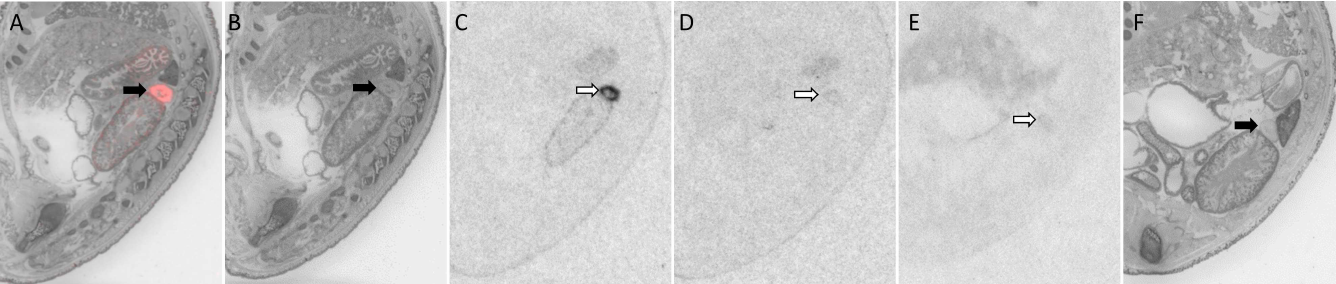
Fig 4. OXTR ligand binding in the adrenal gland of a P0 male mouse. Pseudo-colorcomposite (OXTR in red, cresyl violet counterstain in gray) (A), followedby cresyl violet counterstain (B), with black arrows indicating region of interest. OXTR ligandbindingis indicatedby white arrows in the 0 nM OXT competition(C), followedby 1000 nM OXT competingwith OVTA radioligand to reduce the signal(D). Specific bindingcan be observedon the kidney (C) just belowthe adrenalgland, and this is also competedaway by 1000 nM OXT (D). Nonspecificbindingto lipids in the duodenumcan be seen above the adrenal gland; this faint signal does not change across competition conditions. OXTR ligandbindingin the adrenalgland (or kidney)was not present in OXTR KO mice (E), followedby the post-processed cresyl violet tissue of the OXTR KO (F).